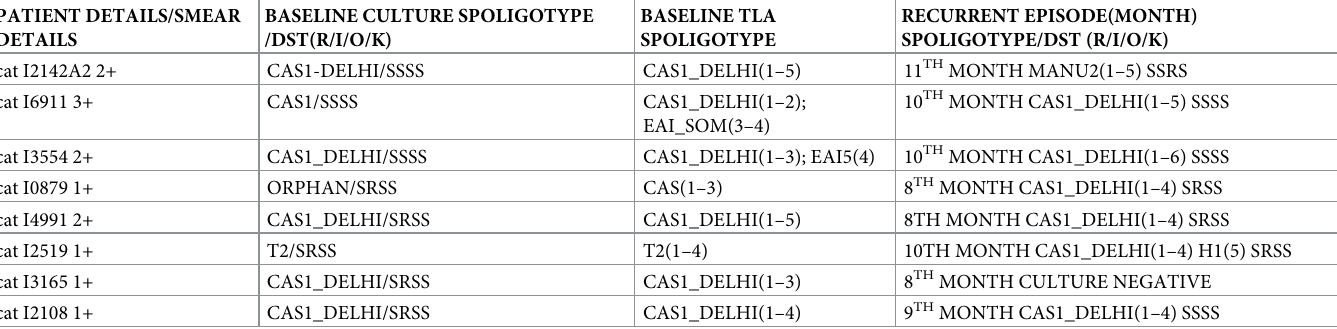
Table 2. Recurrent TB cases: Genotype at baseline and during recurrent episode in cured Rifampicin sensitive TB patients. PATIENT DETAILS/SMEAR